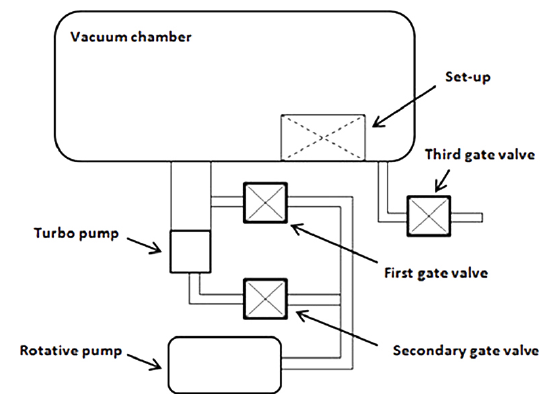
Figure 3. Schematic representation of the experimental set-up. The sample is placed in the effusion cell and heated by a resistance. A PCM (cooled by a cold sink) is positioned in a metal case per- forated in the centre to allow the VOC deposition. The deposition rates are monitored by PCM frequency, whereas the sample temper- ature is monitored (5 ◦ C for each step) by a resistance temperature with PT100 sensor (see Sect. 4.2). In order to avoid flux dispersion, the PCM and effusion cell are located in an isolated micro-chamber and the whole set-up is placed in a vacuum chamber. The resistance is separated by a cold sink in order to obtain a first sublimation step from 25 to 30 ◦ C.